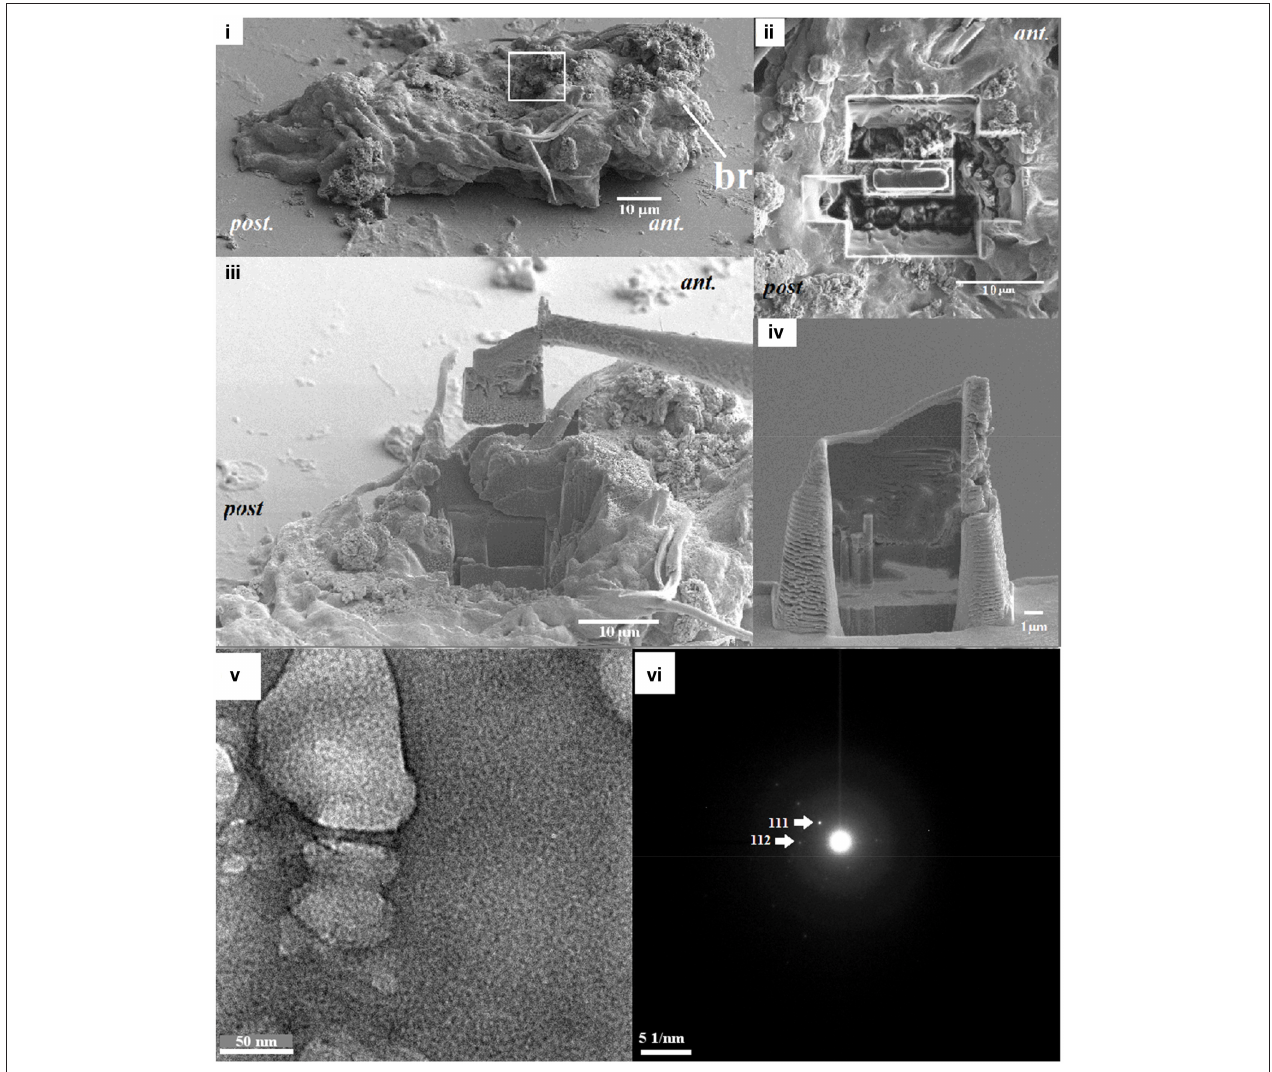
FIGURE 3 | (i) EBSD analysis (white box) showing the region with a Kikuchi pattern was excied to prepare a TEM sample, (ii) the removed surrounding material excised by a focused ion beam (FIB) technique (top view), (iii) the material was lifted using a tungsten probe (side view), (iv) the sample with a final thickness of ∼ 200nm, which was obtained at a lower voltage. Circled area in (v) were analyzed for the presence of selected-area diffraction pattern in a TEM (vi) , showing a single-crystal pattern of